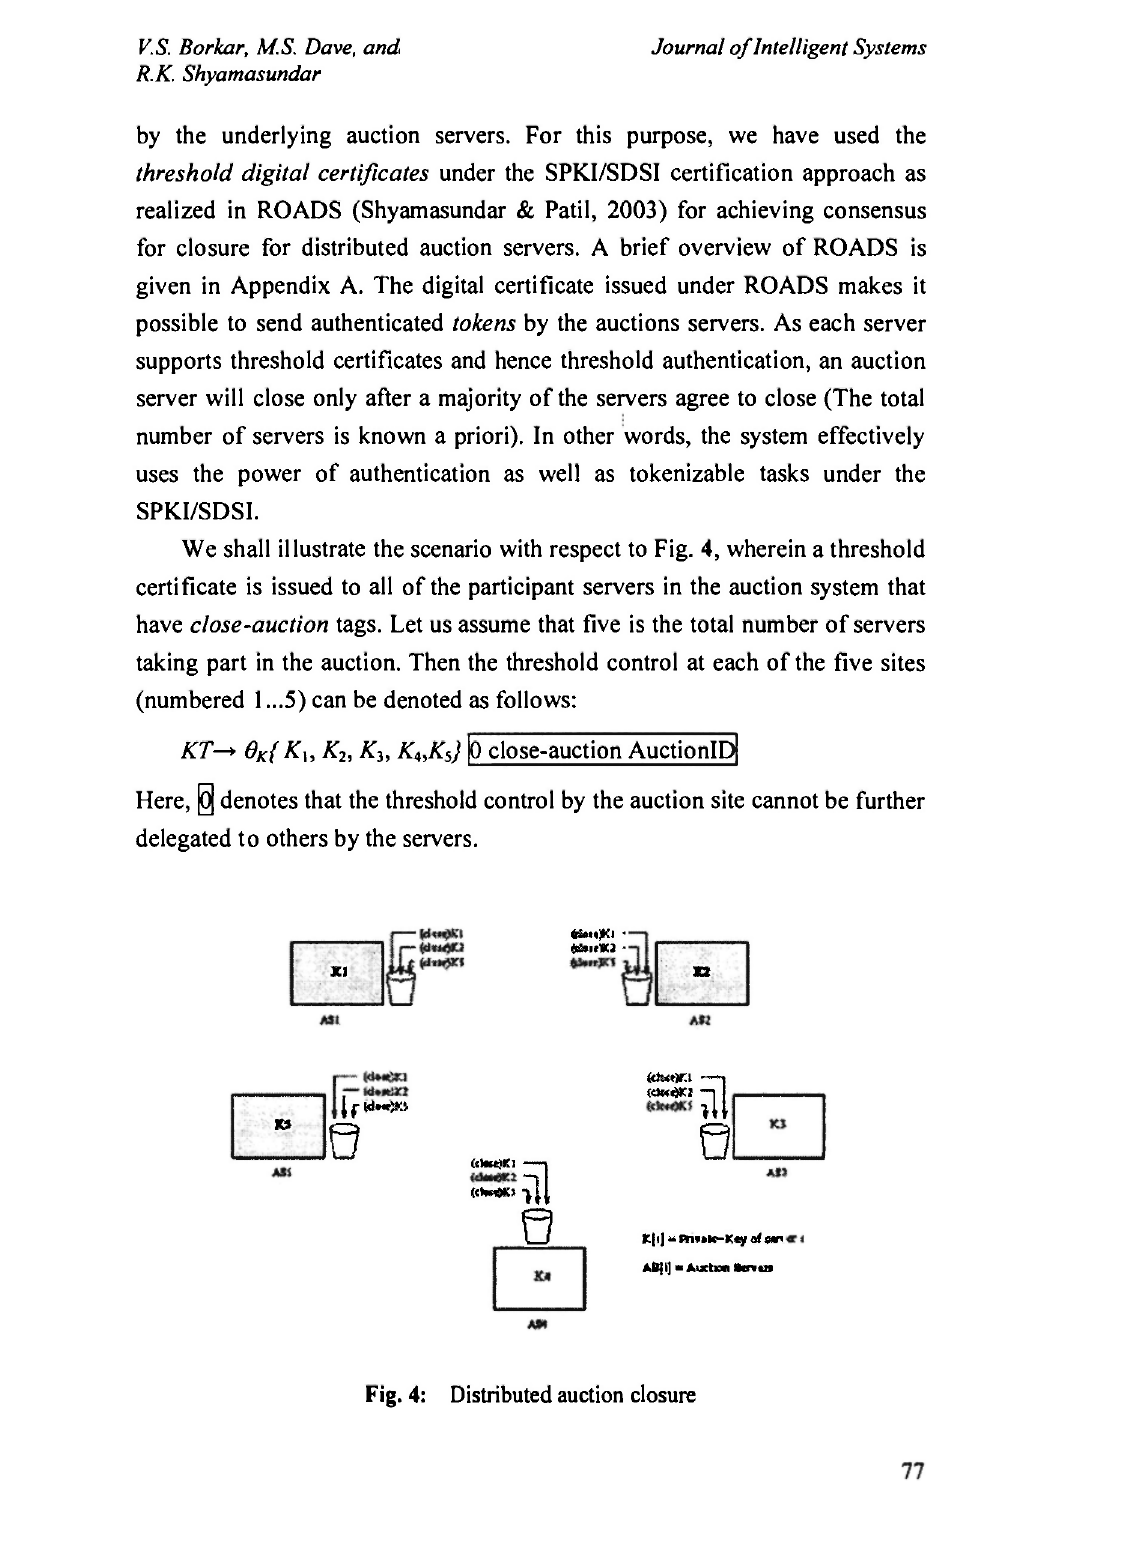
Fig. 4: Distributed auction